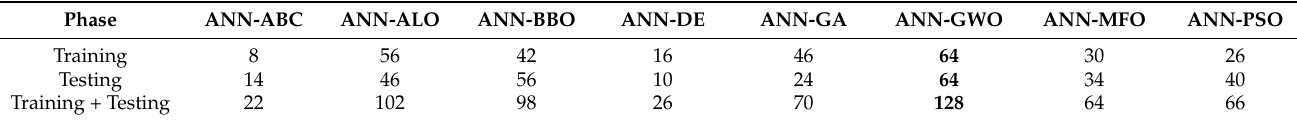
Table 8. Model performance in the training